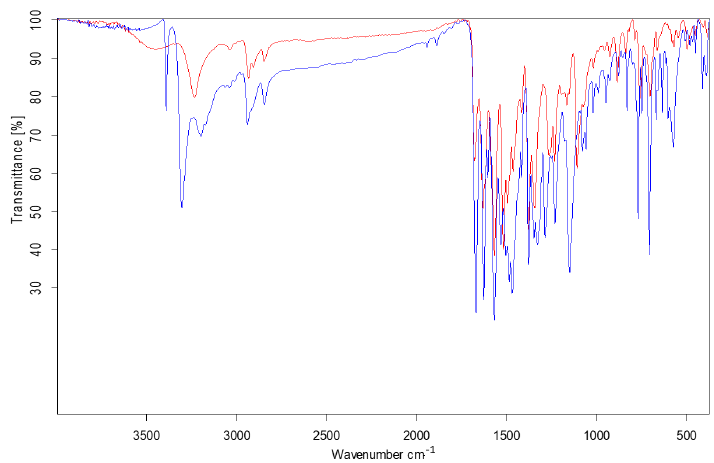
Figure 7. IR spectra of the L compound before (blue) and after (red) the addition of Co 2+